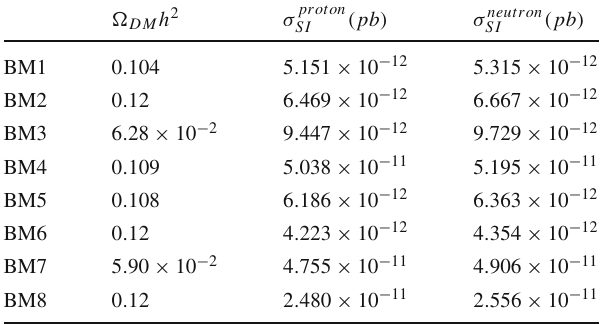
Table 4 The values of the DM relic abundance and the spin- independent cross